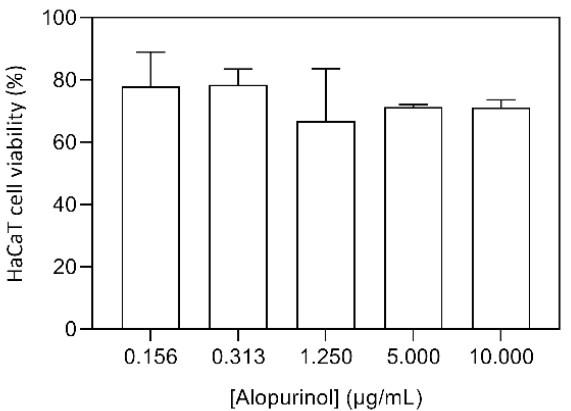
Figure 5. Evaluation of AP loaded NLC cytotoxicity on the HaCaT cell line. Results are expressed as mean ± standard error of a representative experiment.